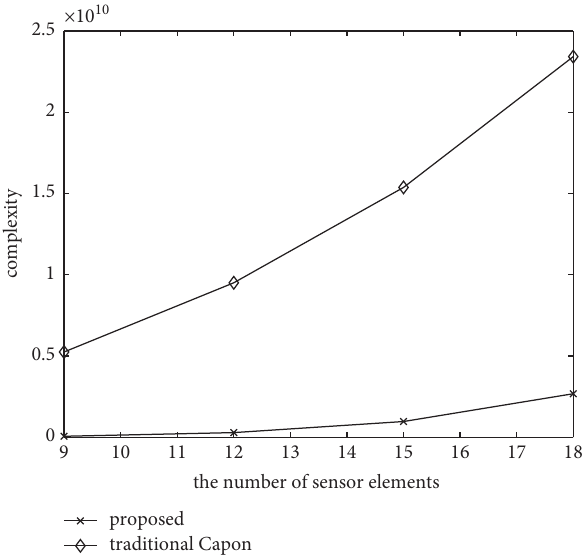
Figure 3: The complexity comparison between the proposed al- gorithm and the traditional Capon